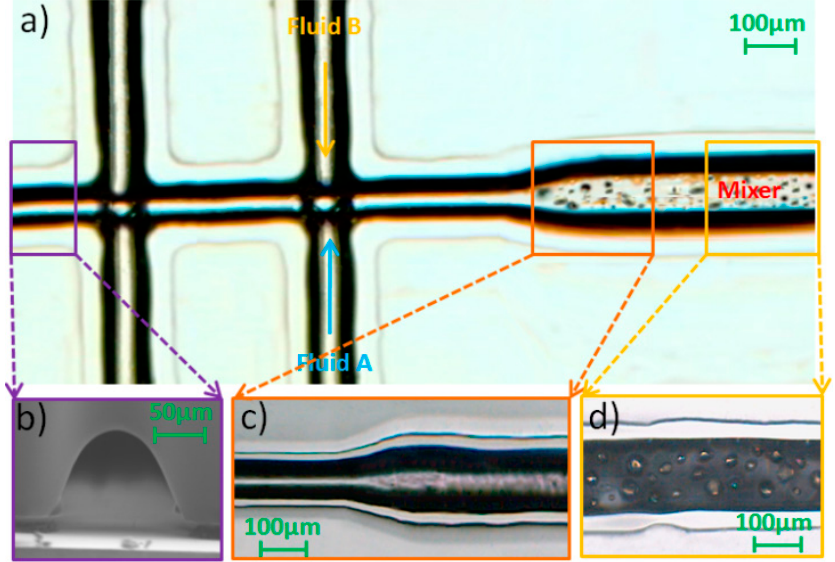
Figure 10. SEM images of the fabricated device showing ( a ) an overall view of the device and ( b ) showing the cross section of the ablated mixing channel; ( c ) showing the inner surface of the mixing channel. (length of mixing channel = 500 µm, applied potential = 300 V/cm).